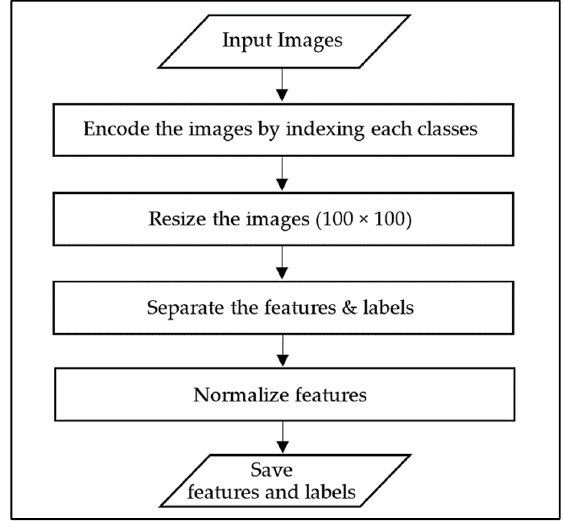
Figure 5. The flowchart of data preprocessing.